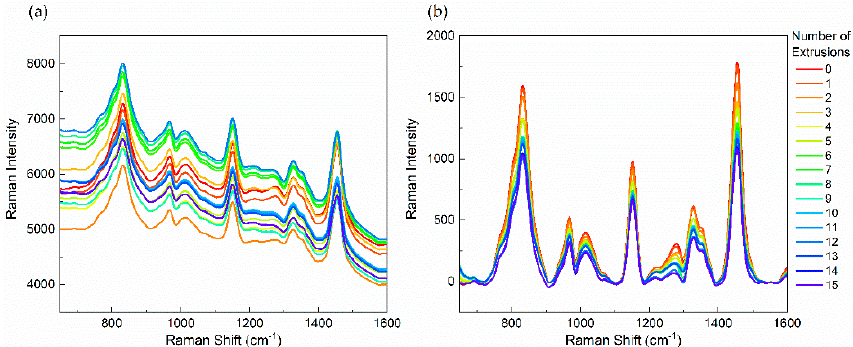
Figure 2. In-line Raman spectra of polypropylene (PP) with different numbers of extrusions. ( a ) raw spectra, ( b ) spectra pretreated by baseline correction.